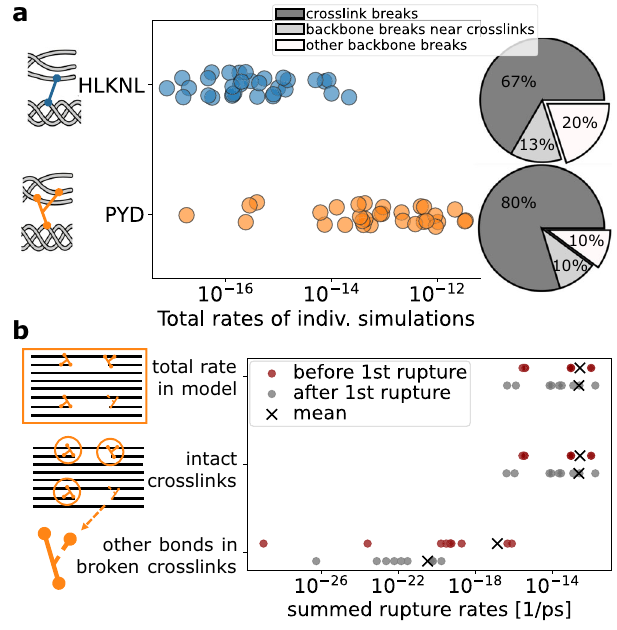
Fig. 4 | Trivalent crosslinks break faster, but (at fi rst) without loosing con- nection. a Comparison of total primary bond rupture rates in simulations with modelshavingdivalent(HLKNL)vs.modelshavingtrivalent(PYD)crosslinks,which show overall higher rates. The ratio of crosslink ruptures to other breakages con- fi rms that the increased rupture rates are indeed due to higher propensities in the crosslinks. b Comparisonofsecondarybondruptureratesbeforeandafterthe fi rst arm in one PYD crosslink broke. The rate in the second arm even decreases, being several orders of magnitude lower compared to the sum in the remaining model. Hence,otherbondswillbreak fi rstandthe fi brilstaysoverallintact.Eachdatapoint is from one of nine simulations with trivalent crosslinks, which we continued after the fi rst rupture in the short PYD